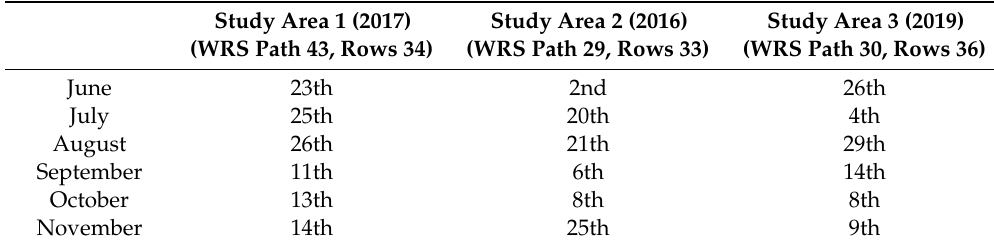
Table 2. Date of images used in the study